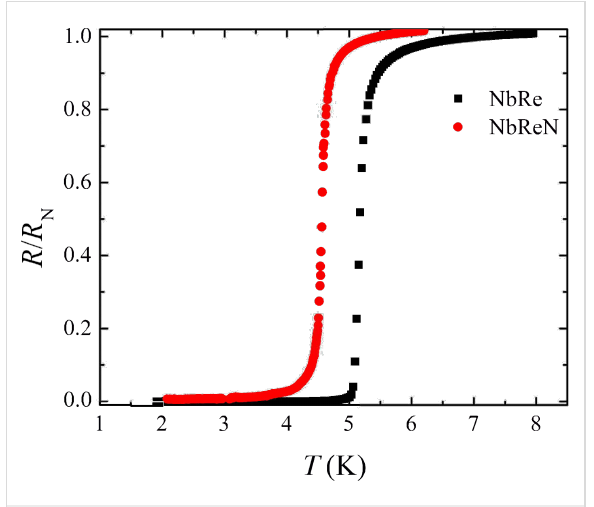
Figure 1: Resistive transition in zero magnetic field of the NbRe (black squares) and NbReN (red circles) microstrips.